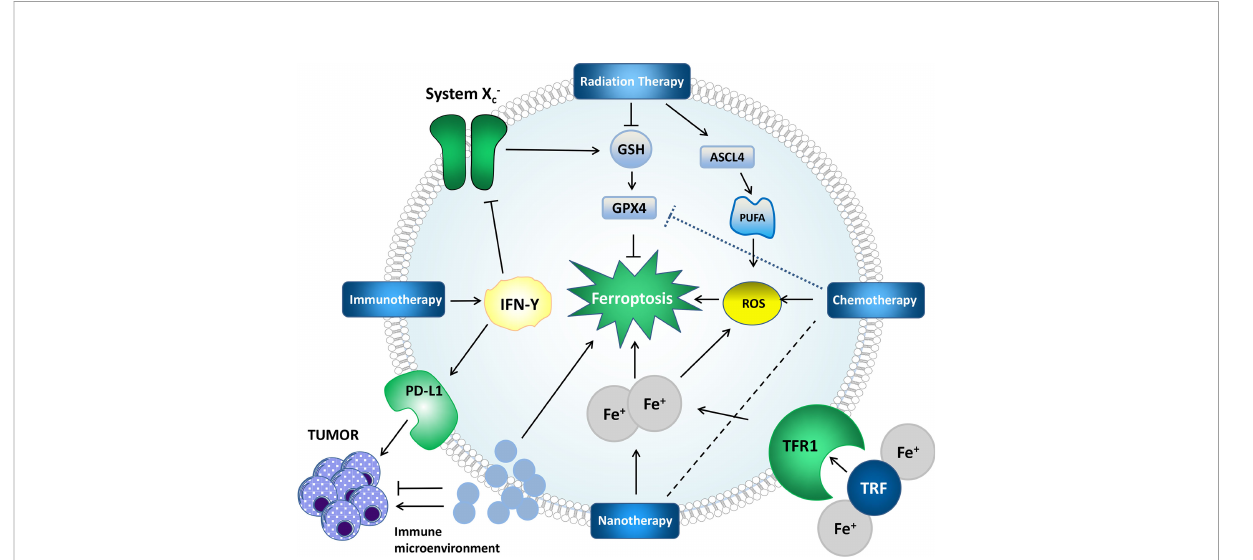
FIGURE 2 Mechanisms by which some treatments affect ferroptosis and tumors. Radiation therapy can generate ROS, induce lipid peroxidation, upregulate ASCL4, promote PUFA synthesis, provide a substrate for lipid peroxidation, deplete GSH and affect GPX4 to affect ferroptosis. IFN- g in immunotherapy can affect system X c- , which further affects ferroptosis through the GPX4 pathway. PD-L1 can directly inhibit tumors. Nanotherapy can deliver iron and chemotherapeutic drugs to cells to achieve better therapeutic effects. The impact of the immune microenvironment on ferroptosis and tumors cannot be ignored.